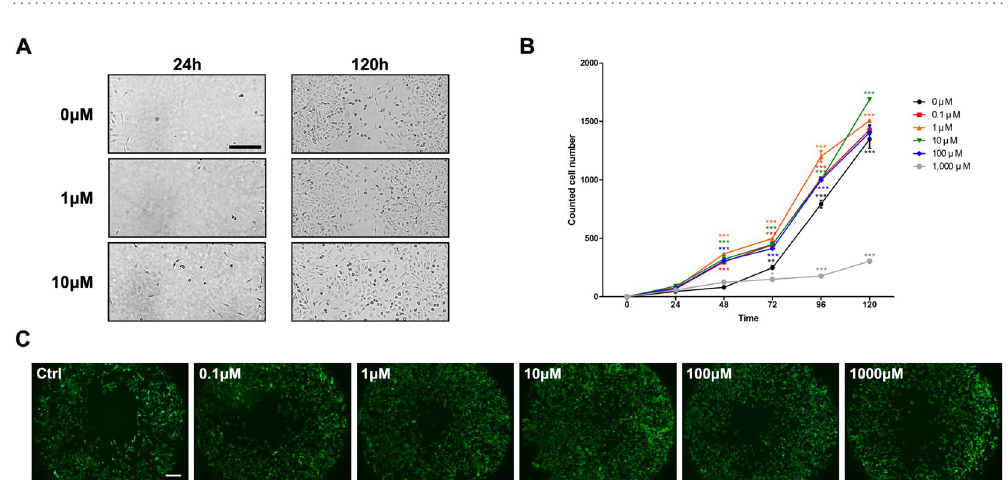
Figure 5. In vitro scratch assay and HCEC migration assay. ( A ) In the scratched area, HCEC repopulation was observed up to 120 h. The addition of NaNO 2 increased HCEC repopulation significantly. The scratched area was completely covered at 120 h following the addition of 10 μ M NaNO 2 compared to the negative control (0 μ M). ( B ) The number of cells counted at the scratched area is shown. Cell numbers were significantly increased with the addition of NaNO 2 (0.1 to 100 μ M); NaNO 2 (10 μ M) showed the highest cell concentration when measured at 120 h. However, a high concentration of NaNO 2 (1000 μ M) significantly decreased cell counts in the scratched area compared to the negative control. ( C ) An image of the central detection zone in cell migration assay was captured, in order to compare the pattern of cell migration. The positive effect of NaNO 2 on HCEC migration was most prominent in conjunction with the 10 μ M concentration. * p < 0.05, ** p < 0.01, *** p <